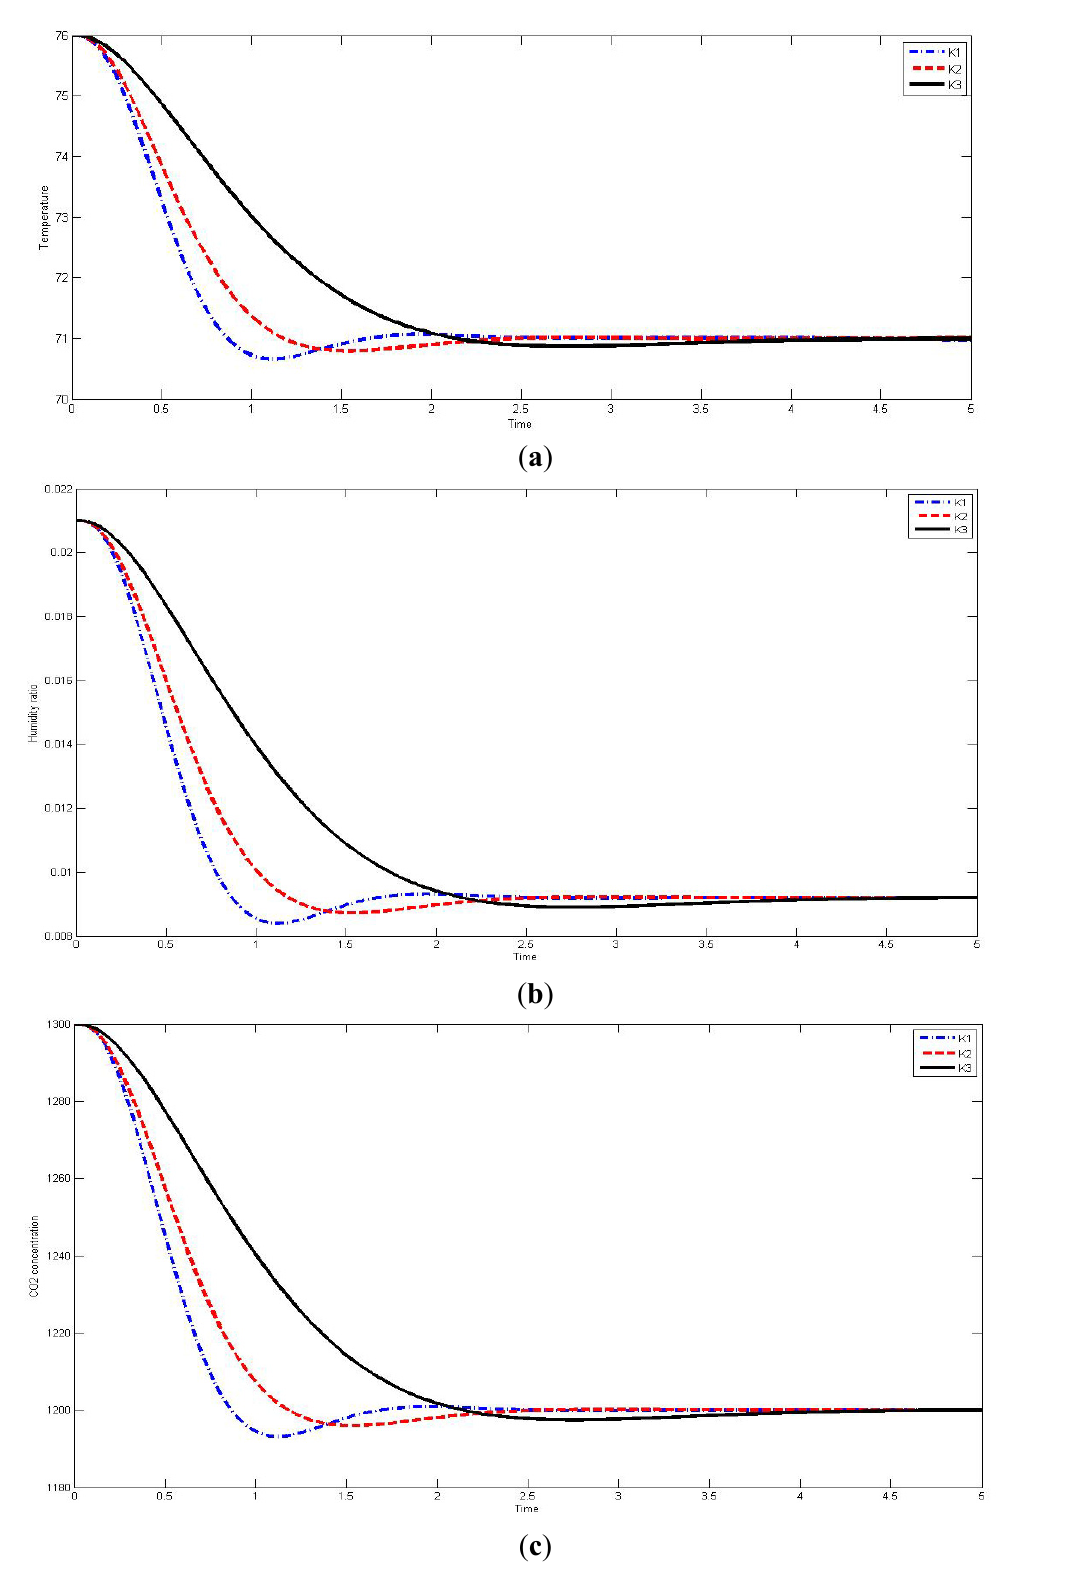
Figure 5. ( a ) Temperature response by LQR; ( b ) Humidity ratio response by LQR; ( c ) CO concentration response by